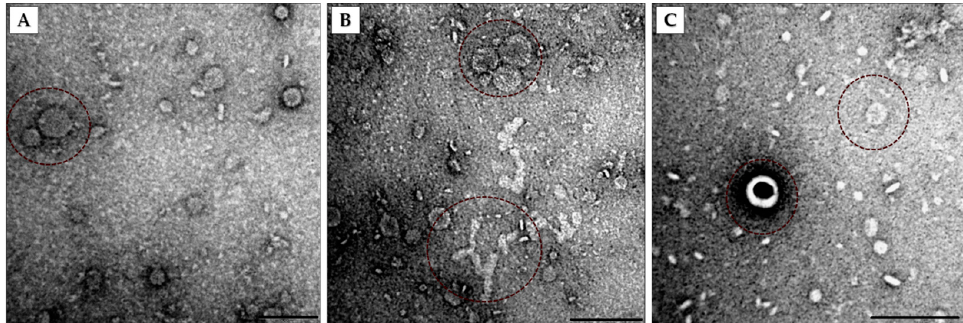
Figure 3. Transmission electron microscopy of OMVs isolated from Pbr1692 in the stationary growth phase. ( A ) The TEM image shows OMVs of different sizes. ( B ) The image shows OMV aggregates (top) and the OMV chain-like morphology (bottom). ( C ) The dotted circles indicate a single-membrane vesicle and a double-membrane OIMV vesicle with a halo around. Scale bars = 200 nm.